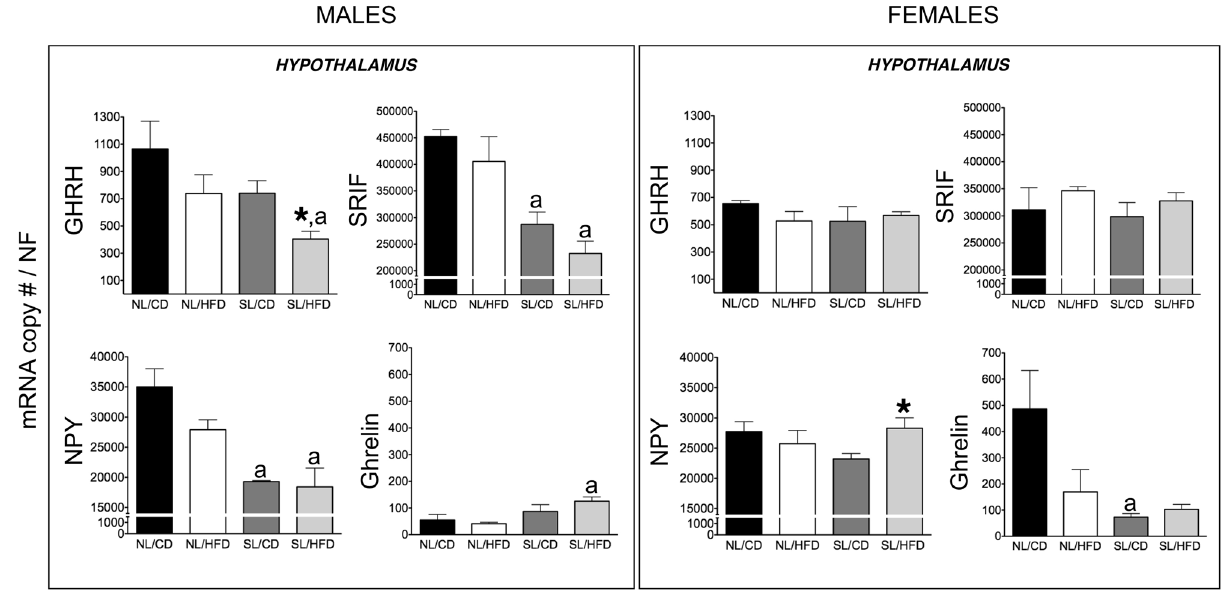
Figure 4. Hypothalamic GHRH, SRIF, NPY and ghrelin mRNA levels in male ( left panels ) and female rats ( right panels ) subjected or not to overfeeding during lactation (SL vs. NL) and/or HFD after weaning (HFD vs. CD). mRNA copy numbers were determined by qPCR and adjusted by a Normalization Factor (NF) in each sample obtained from the expression levels of three housekeeping genes ( β-actin , Hprt and C yclophilin A ).